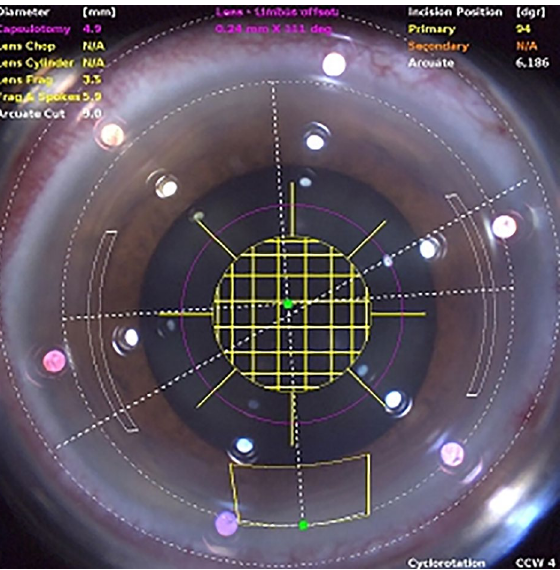
Figure 1. An example of programmed femtosecond laser-assisted astigmatic keratotomy in femtosecond laser assisted cataract